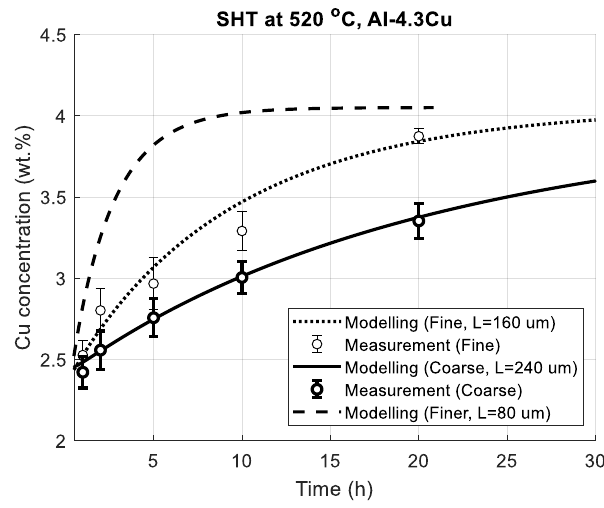
Figure 10. Simulated and measured Cu concentration in the matrix during solution heat treatment at 520 °C for the Al-4.3Cu alloy with various microstructures.